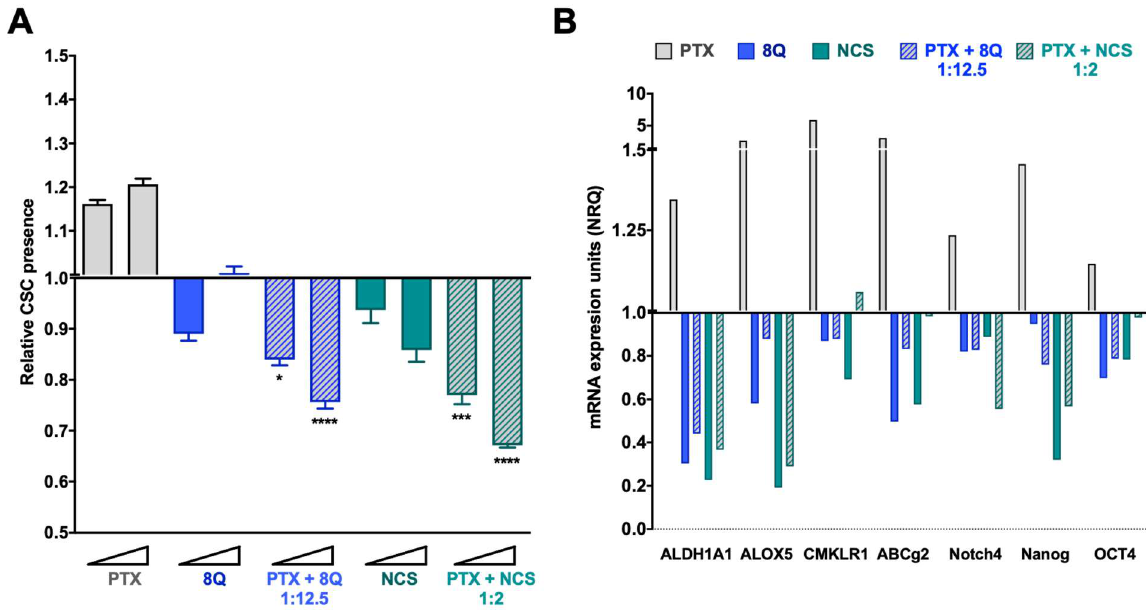
Figure 5. Anti-CSC activity of 8Q and NCS in combination with PTX in the MDA-MB-231 fluorescent CSC model. ( A ) Relative CSC-tdTomato+ presence determined by flow cytometry and referred to control condition. Values below than, equal to or above 1 indicate reduction, maintenance or increase of CSC-tdTomato+ cells within population, respectively. Data are represented as the mean ± SEM of three independent experiments. Statistic t-test analyses were performed to compare drug combinations with single anti-CSC drug treatments at the corresponding equivalent drug dose (* p < 0.05, *** p < 0.001, **** p < 0.0001). ( B ) Changes in the stem cell gene expression profile determined by quantitative RT-PCR. Results are expressed as normalized relative quantities (NRQ) and referred to as control conditions. Concentrations tested for drugs were 0.5 and 1 µM for PTX, 6.25 and 12.5 µM for 8Q, 1 and 2 µM for NCS and the corresponding combined ratios.